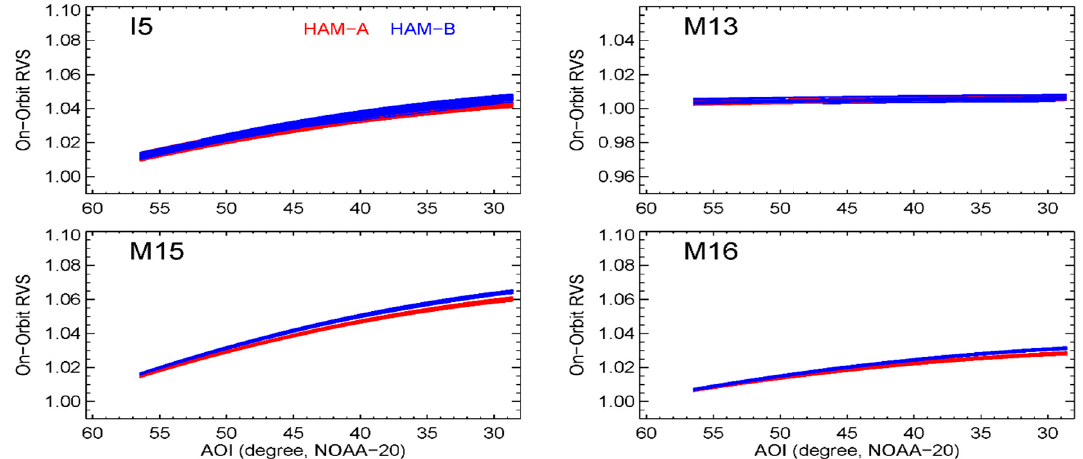
Figure 7. NOAA-20 bands I5, M13, and M15–M16 detector level on-orbit RVS derived using the Wang et al. method, after smoothed using 2 nd order